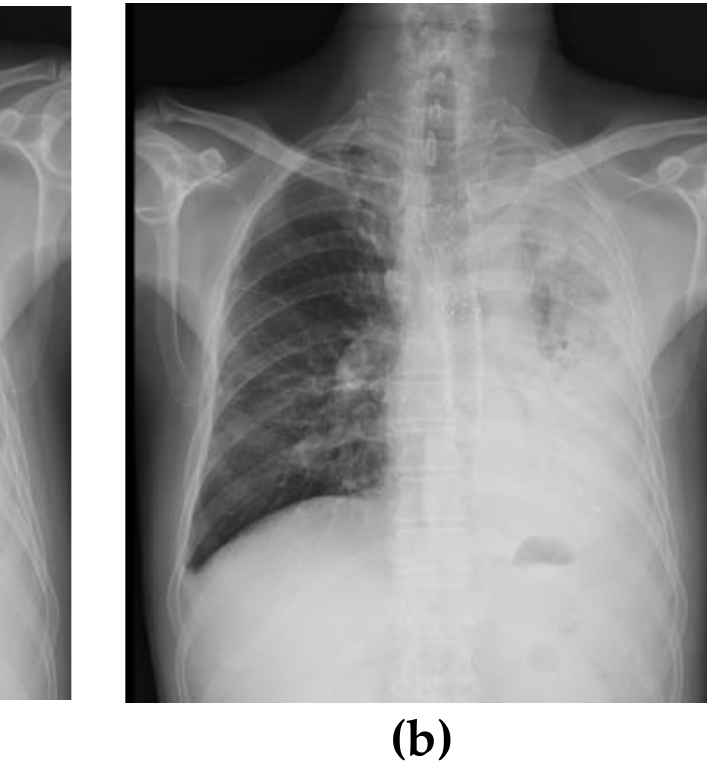
Figure 3. Bronchoscopic view of significant extrinsic compression of the posterior wall of trachea. The left main bronchus was also completely occluded by external compression of the esophageal stent at the site of tracheal bifurcation. LMB, left main bronchus; RMB, right main bronchus .